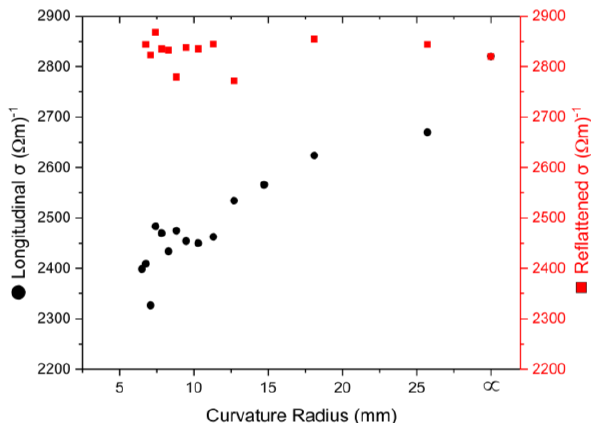
Figure 4. Behaviour of longitudinal and re-flattened conductivity with radius for negative bending, at room temperature (20 °C). The former showed a decreasing trend reaching a minimum of 2399 (Ωm) −1 at 6.5 mm, while the latter remained stable in the whole range showing no mechanical failure.